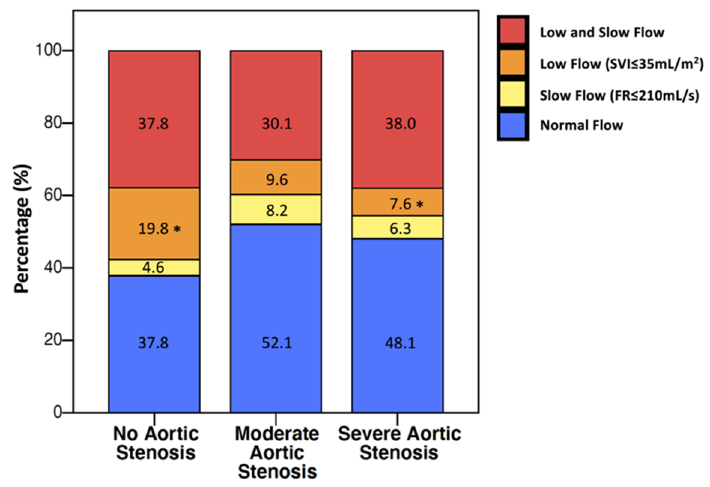
Figure 2. Distribution of flow status profiles according to stroke volume index (SVI) and flow rate (FR). * Adjusted for multiple comparisons p value = 0.029. All the other comparisons were not significant.